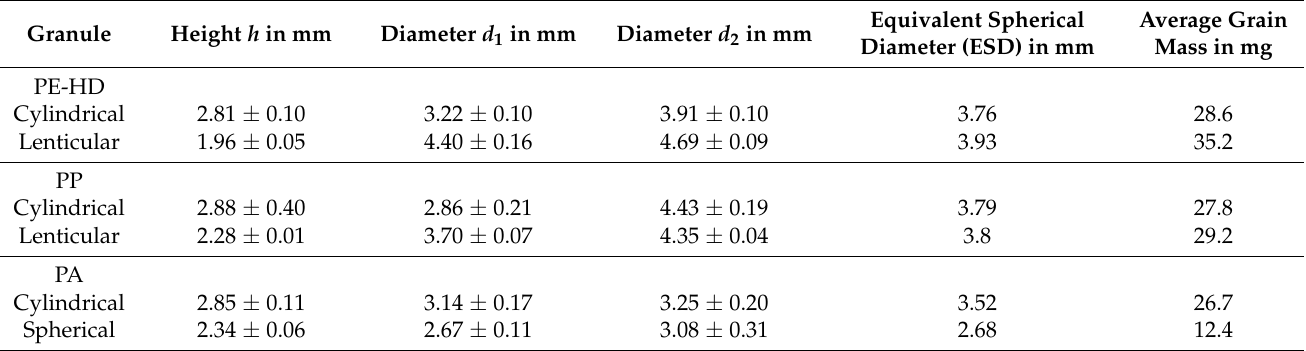
Figure 1. Schematic representation of ( a ) the lenticular, ( b ) the cylindrical and ( c ) the spherical granule shapes and dimensions. Table 1. Geometrical plastic granule